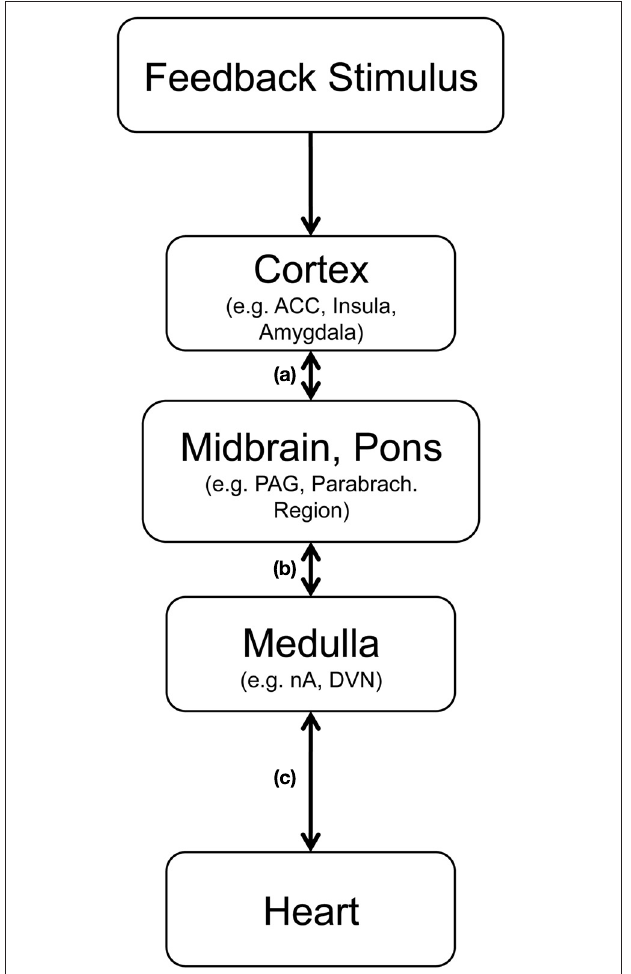
FIGURE 4 | Hypothetical pathway for abstract feedback stimuli to trigger vagally mediated cardiac reactions, (adapted from Jordan, 2005; Thayer and Lane, 2007). After sensory processing feedback properties are analyzed in cortical structures including the anterior cingulate cortex (ACC), the insula and the amygdala. Relevant information is transmitted to the periaqueductal gray in the midbrain and to parabrachial region in the pons (a) . From there medullar regions including the nucleus tractus solitarius, the nucleus ambiguous (nA) and dorsal vagal nucleus (DVN) can be activated (b) . Myelinated cardiac preganglionic vagal neurons, which have a high density of 5-HT receptors, have their cell-bodies in the nA and modulate heart rate by projecting to the sinoatrial node (c)